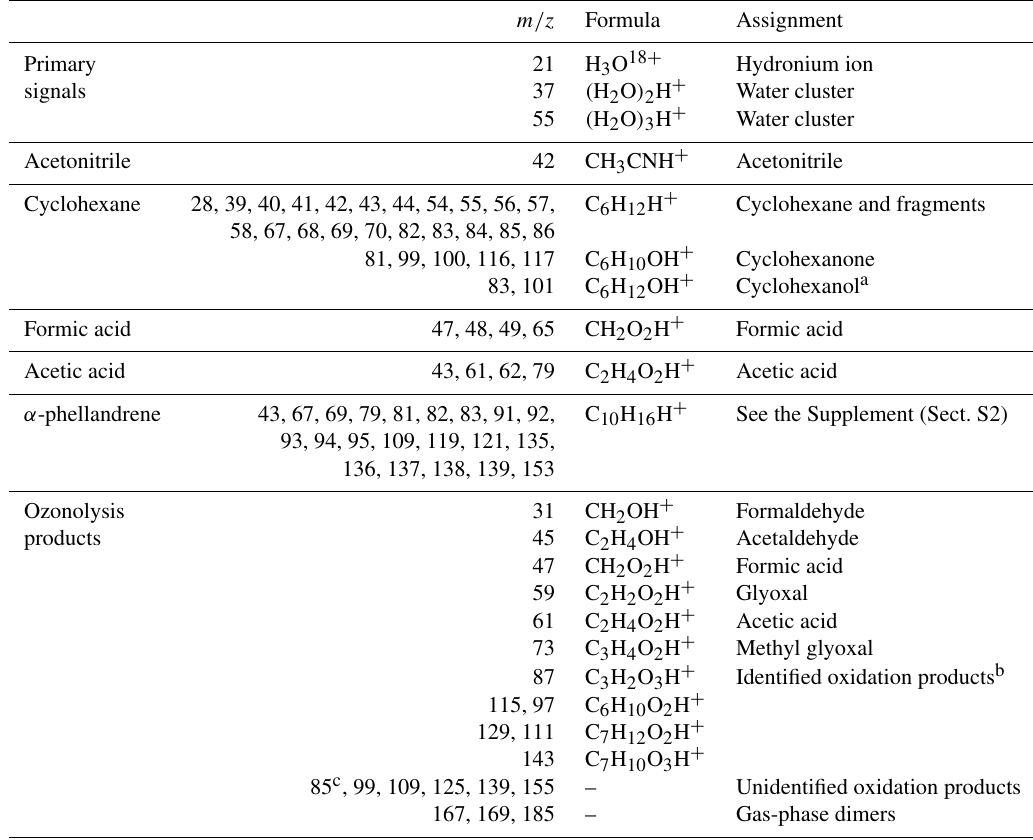
Table 2. Identified ions detected by the PTR-TOF. Refer to Fig. 3 for product structures.